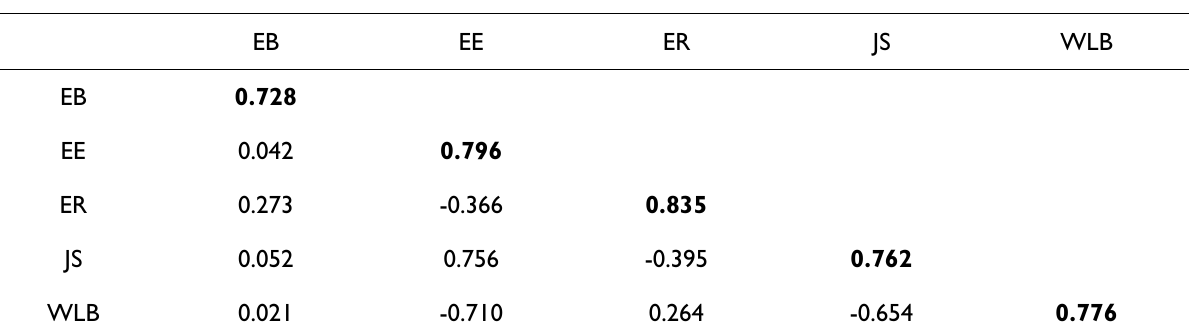
Table 3. Result of Discriminant